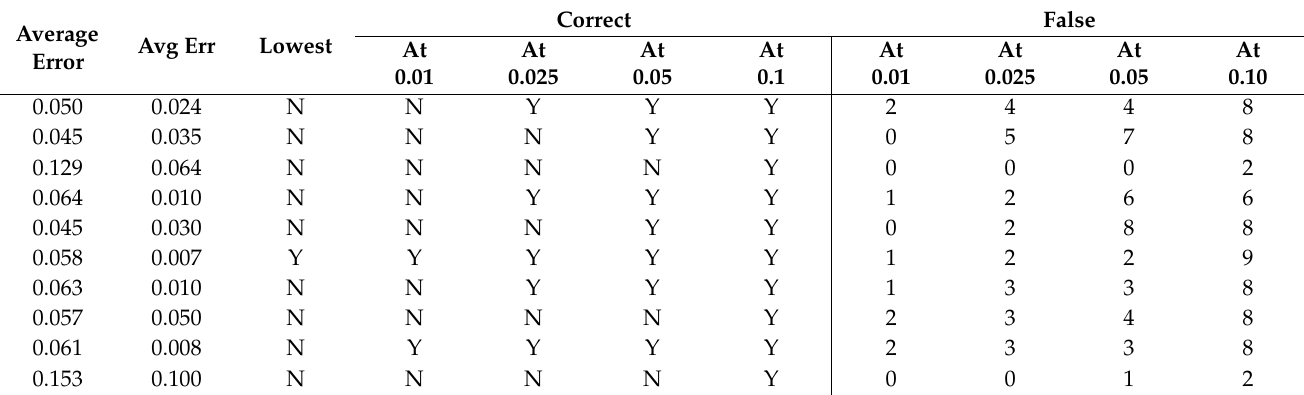
Table A75. Set 1, trials 41–50 summary data (single 0.5 PR value).